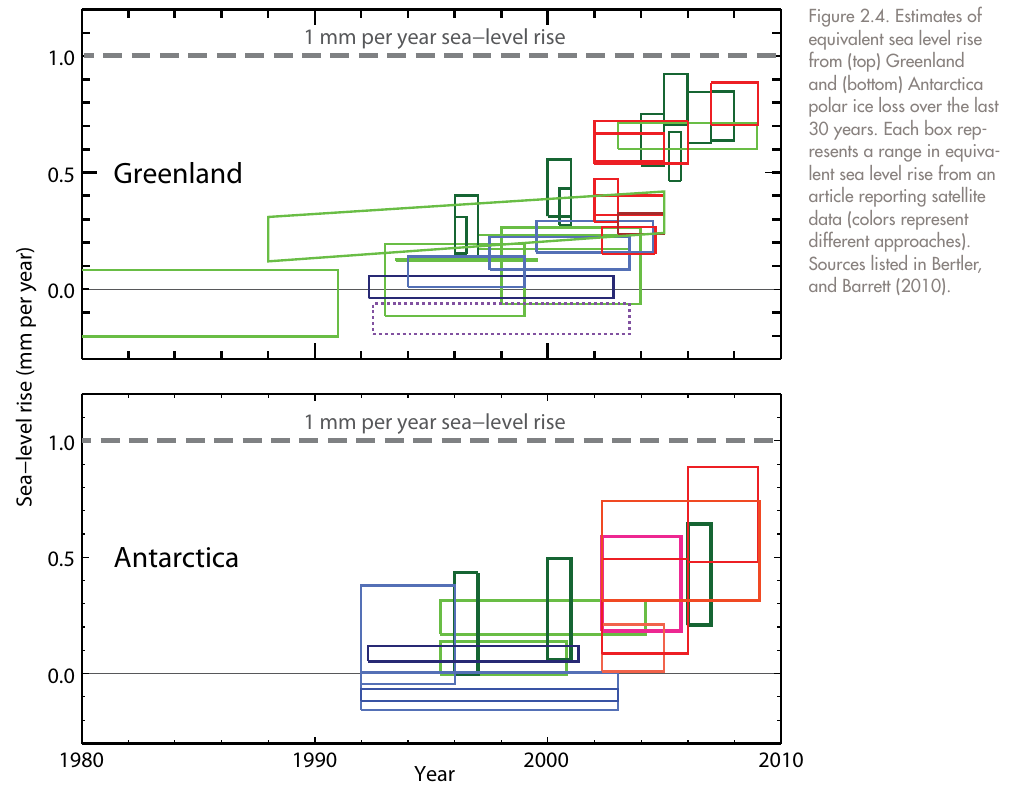
figure 2.4. estimates of equivalent sea level rise from (top) greenland and (bottom) antarctica polar ice loss over the last 30 years. each box rep- resents a range in equiva- lent sea level rise from an article reporting satellite data (colors represent different approaches). sources listed in Bertler, and Barrett (2010).